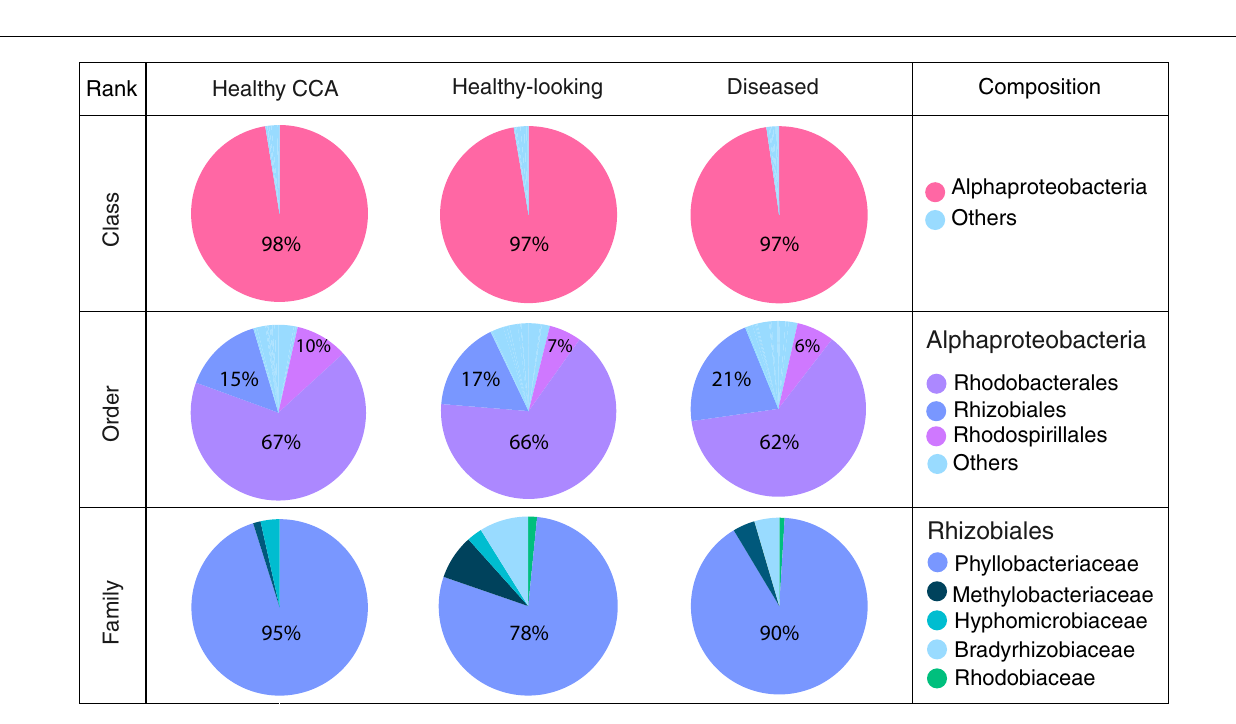
Frontiers in Microbiology |